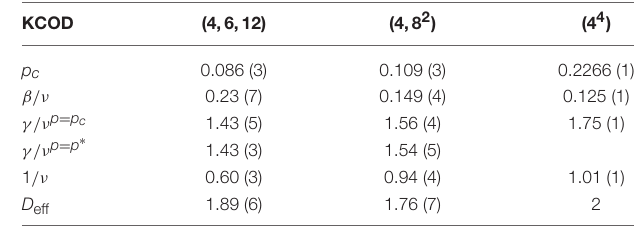
TABLE 2 | Critical parameter, exponents and effective dimension for KCOD model on (4,6,12) and (4,8 2